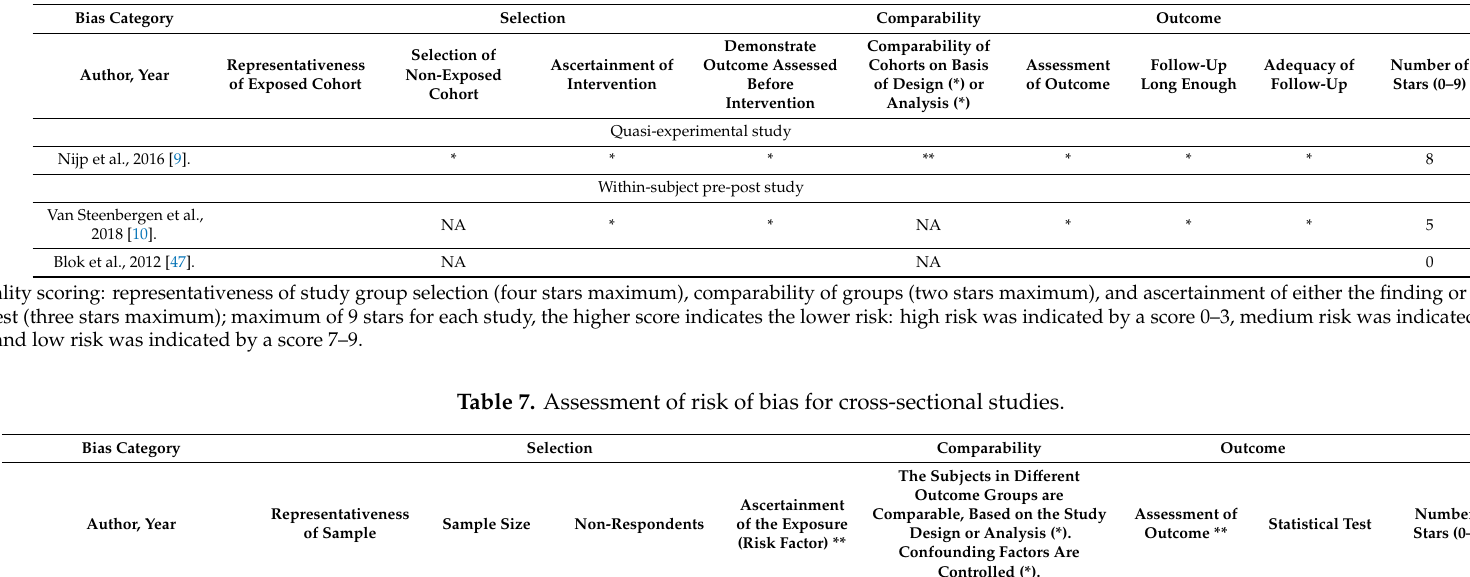
Table 6. Assessment of risk of bias for intervention studies.